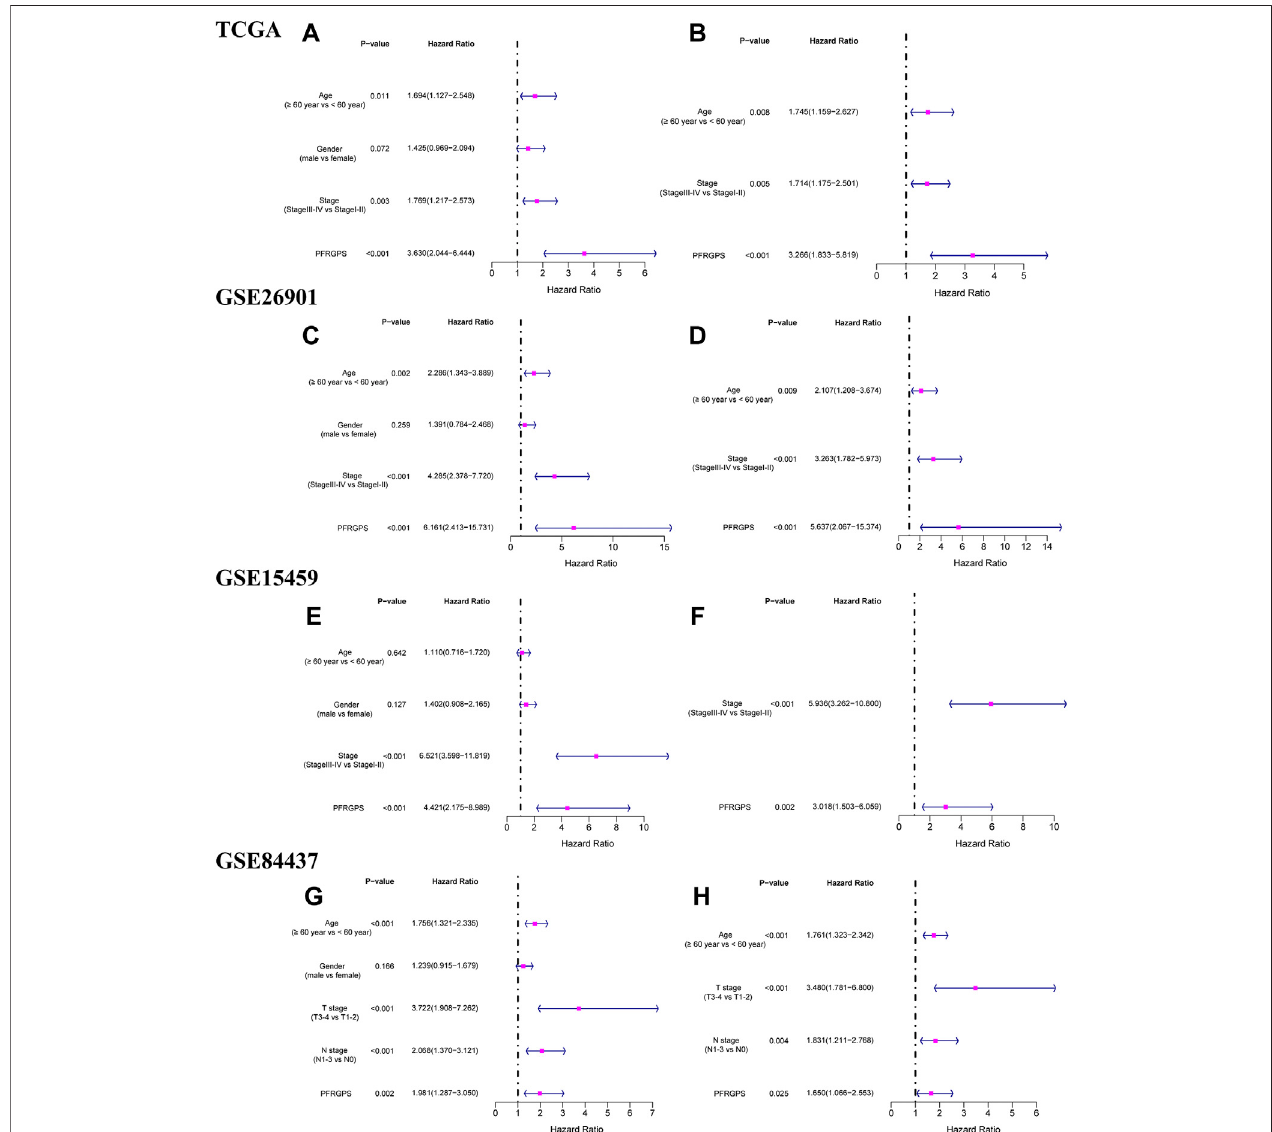
FIGURE 5 | Independent prognostic analyses of prognostic models were performed. The forestplot of univariable Cox regression analysis of PFRGPS and clinical characteristics in (A) TCGA, (C) GSE62901, (E) GSE15459, (G) GSE84437. The forestplot of multivariable Cox regression analysis of PFRGPS and clinical characteristics in (B) TCGA, (D) GSE62901, (F) GSE15459, (H) GSE84437. PFRGPS, platelet function-related genes prognostic